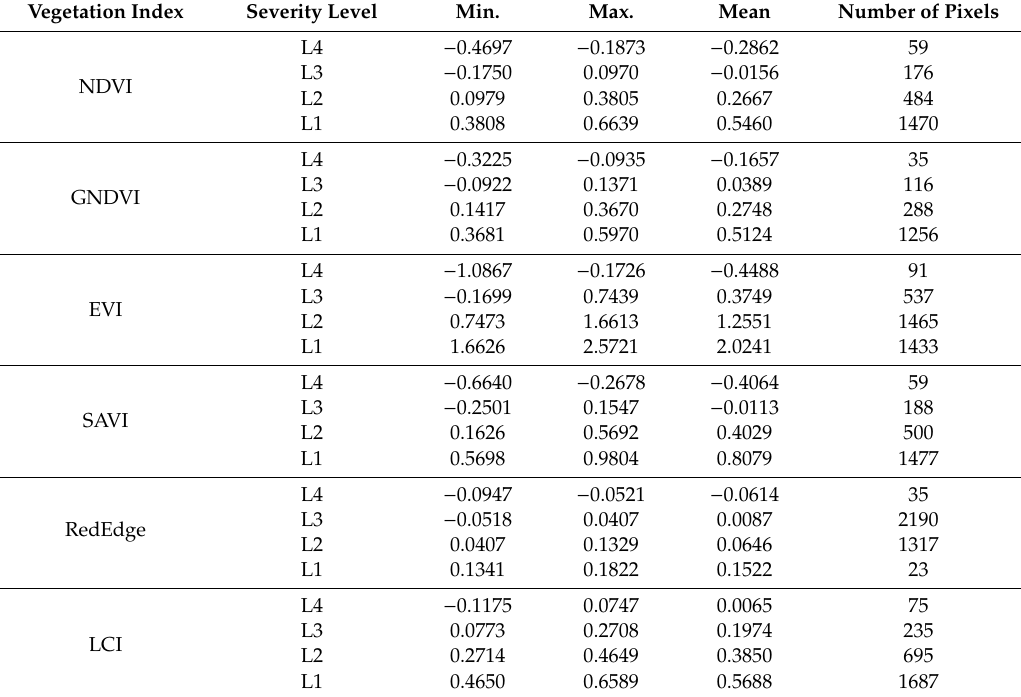
Table 4. Descriptive statistics of di ff erent severity levels of cotton root rot in Field